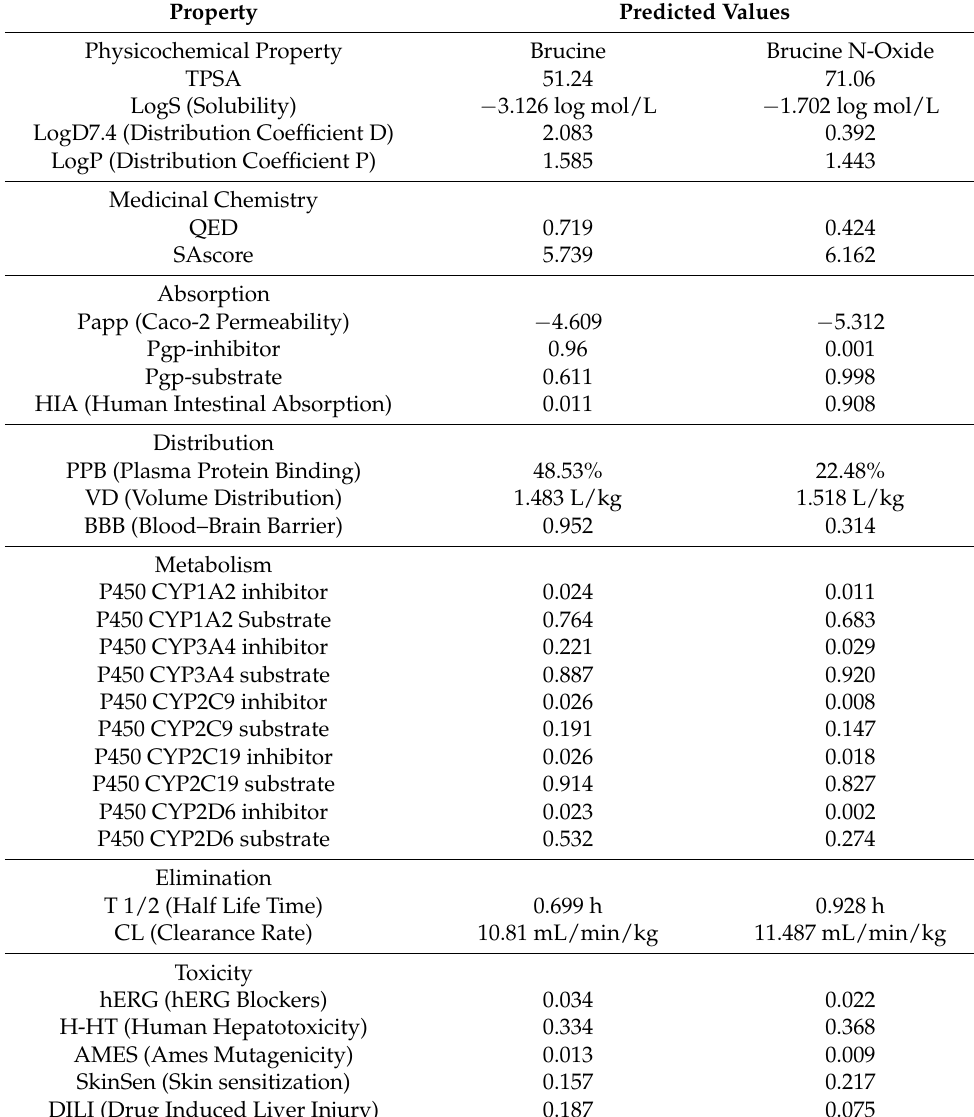
Table 1. Predicted values of physicochemical, medicinal chemical, and ADMET properties of BRU and